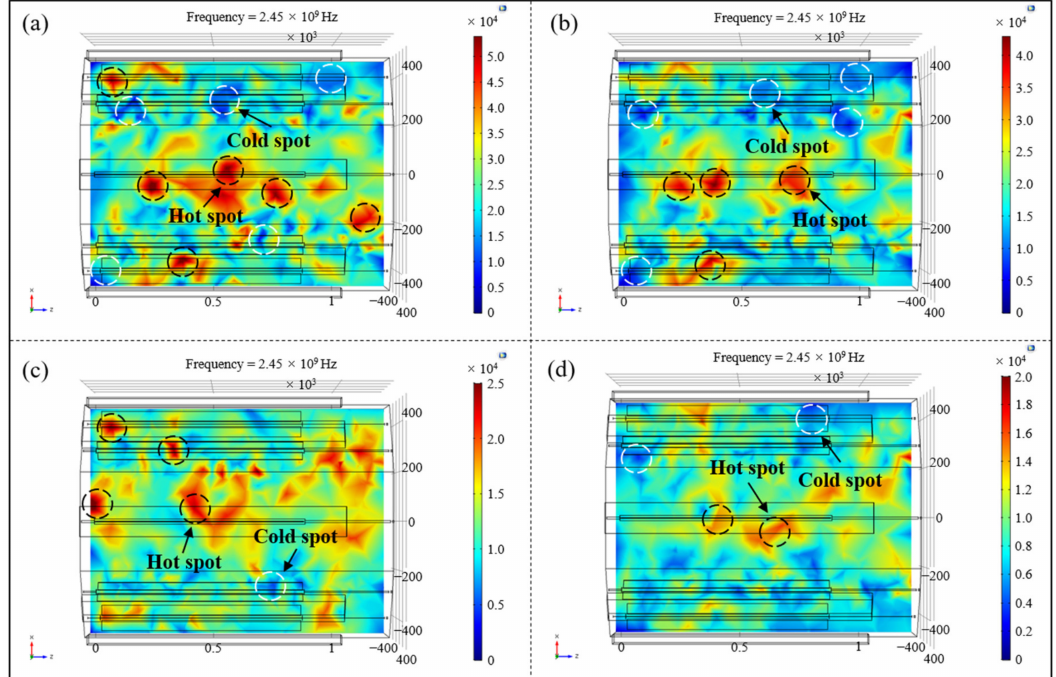
Figure 6. The electric field nephograms on the loading platform of different working conditions: